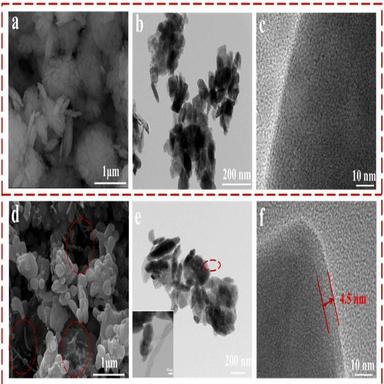
SEM (a, d); TEM (b, e) and HRTEM (c, f) images of LiFePO4 and LiFePO4@MWCNTs composite.